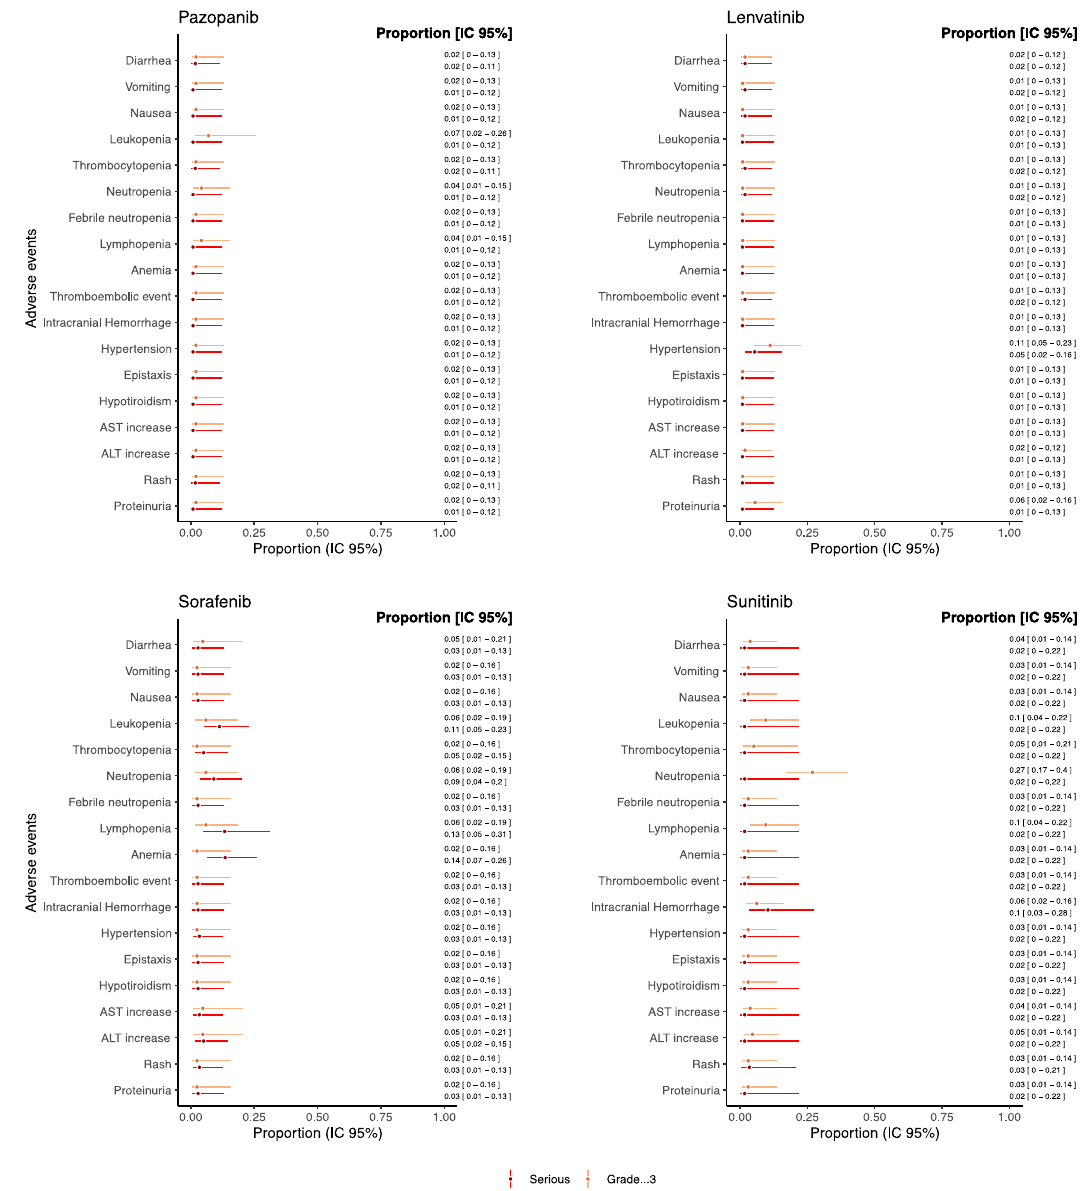
Figure 4. Proportions of serious/grade ≥ 3 AEs for pediatric patients receiving anti-angiogenic drugs as monotherapies.